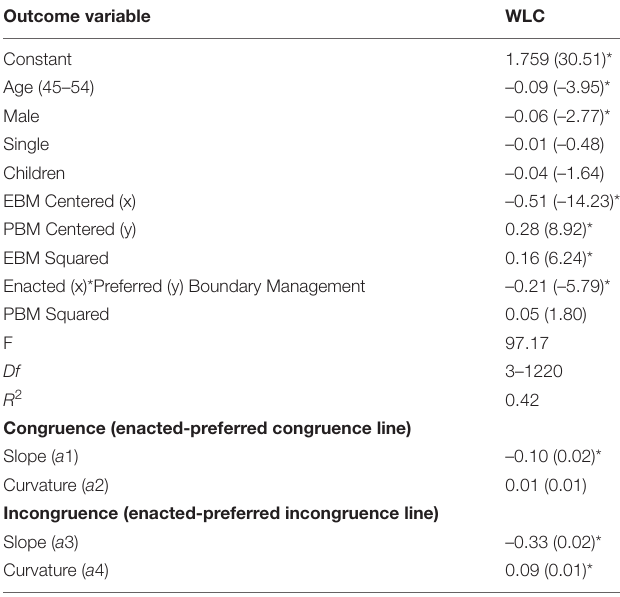
TABLE 2 | Polynomial regression analysis results of Preferred and Enacted Boundary Management, respectively, and their interaction, i.e., Boundary Management (in)Congruence, predicting Work-Life